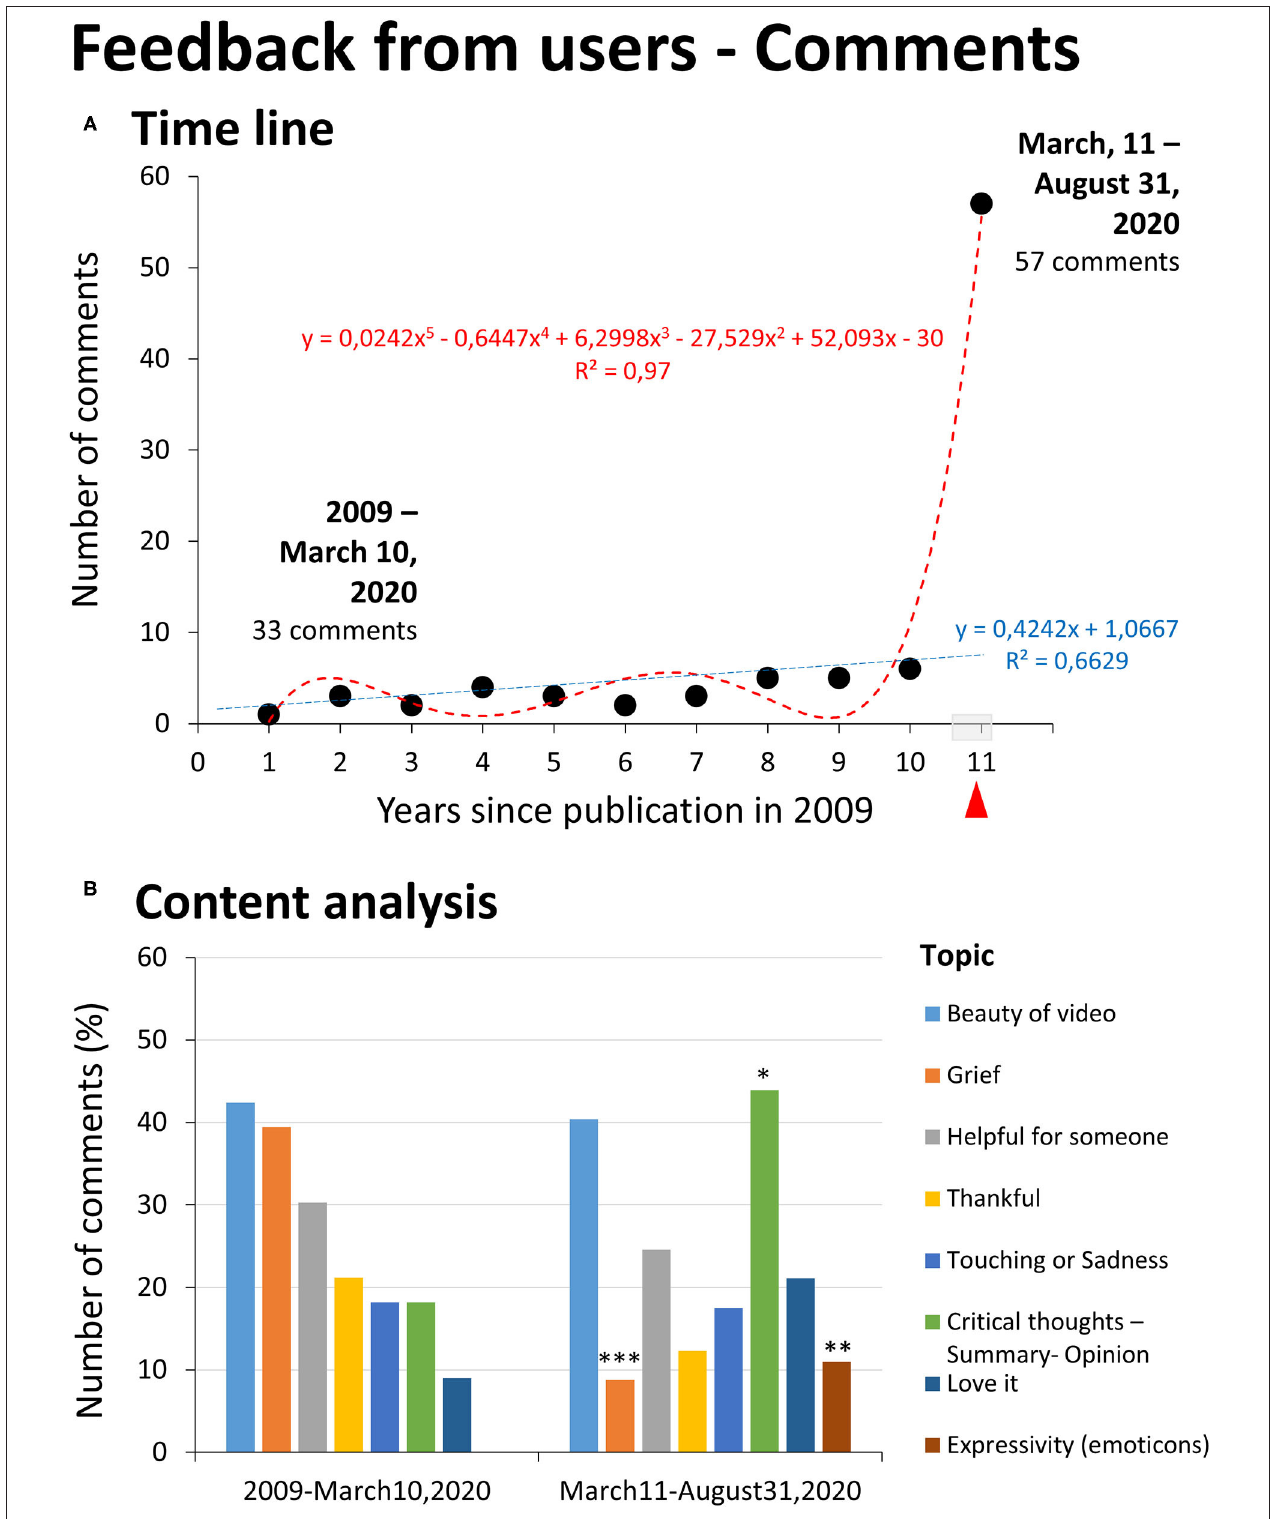
FIGURE 2 | User’s feedback as commentaries. (A) Time line, Statistics: Time line regression analysis. (B) Content analysis identifying 8 topics as described in the legend. Statistics: Chi-square, * p < 0.05; ** p < 0.01; *** p < 0.001 vs. historic (2009-March 10, 2020).